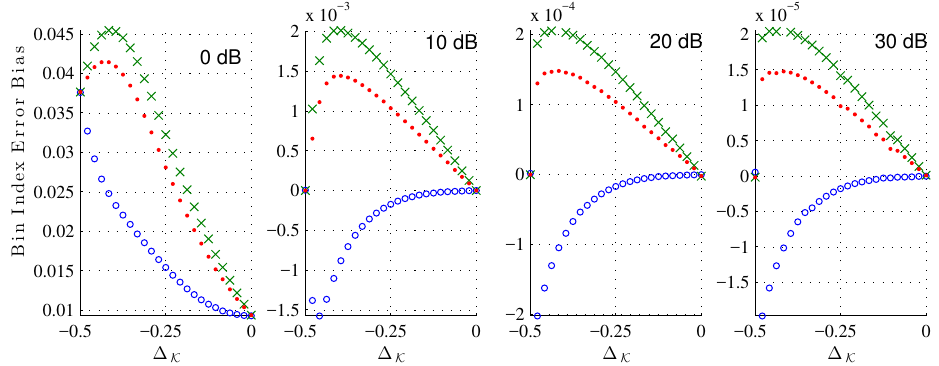
◦ × ), the LQIFFT ( ), and the XQIFFT (